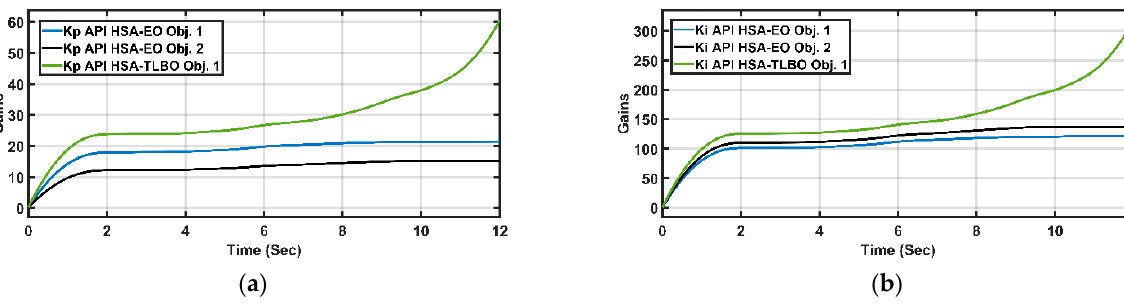
Table 4. Numerical comparison between the controllers at normal second case.